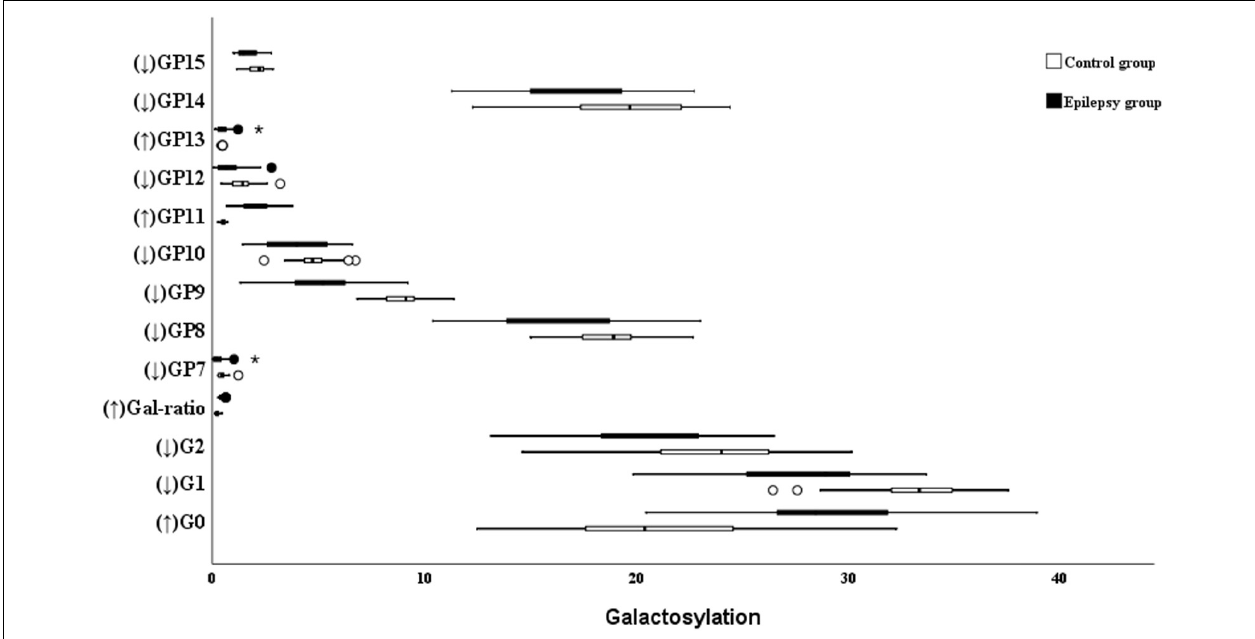
FIGURE 2 | Galactosylation on Ig G in Epilepsy patients and the healthy controls. GP, glycan peak; G, galactose; ↑ , the glycan in Epilepsy group in significantly higher than that in the controls; and ↓ the glycan in Epilepsy group in significantly lower than that in the controls. *Represents the extreme values in the sample data.